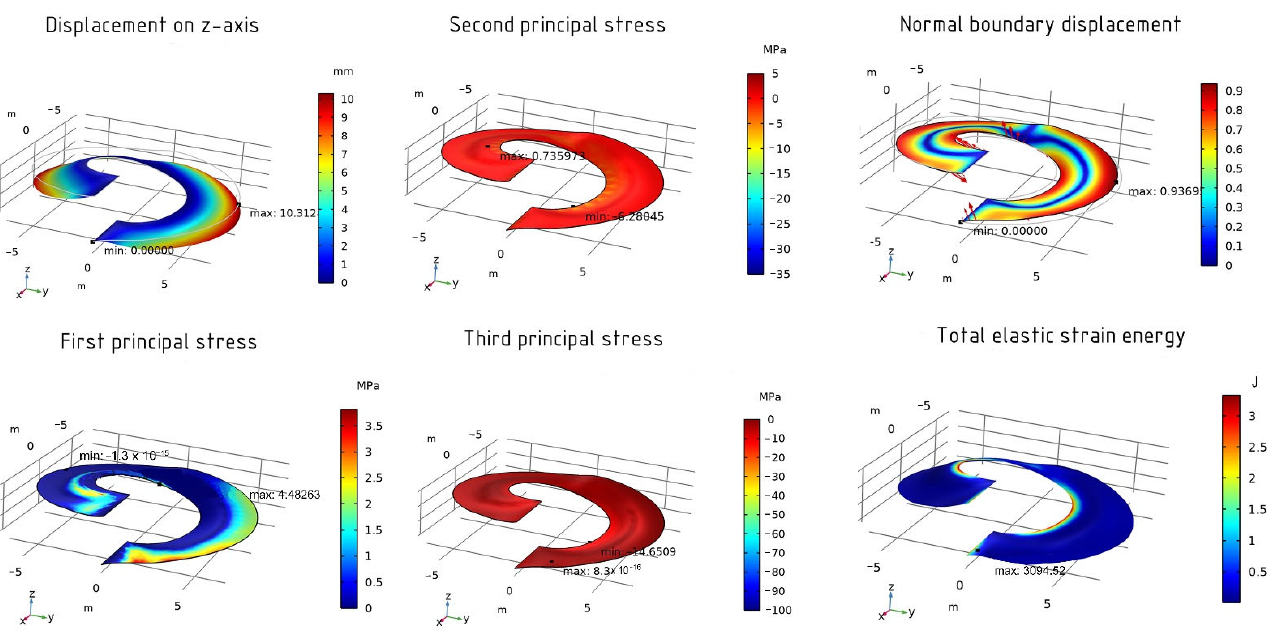
Figure 18. The results of the optimized shell using the SNOPT method.